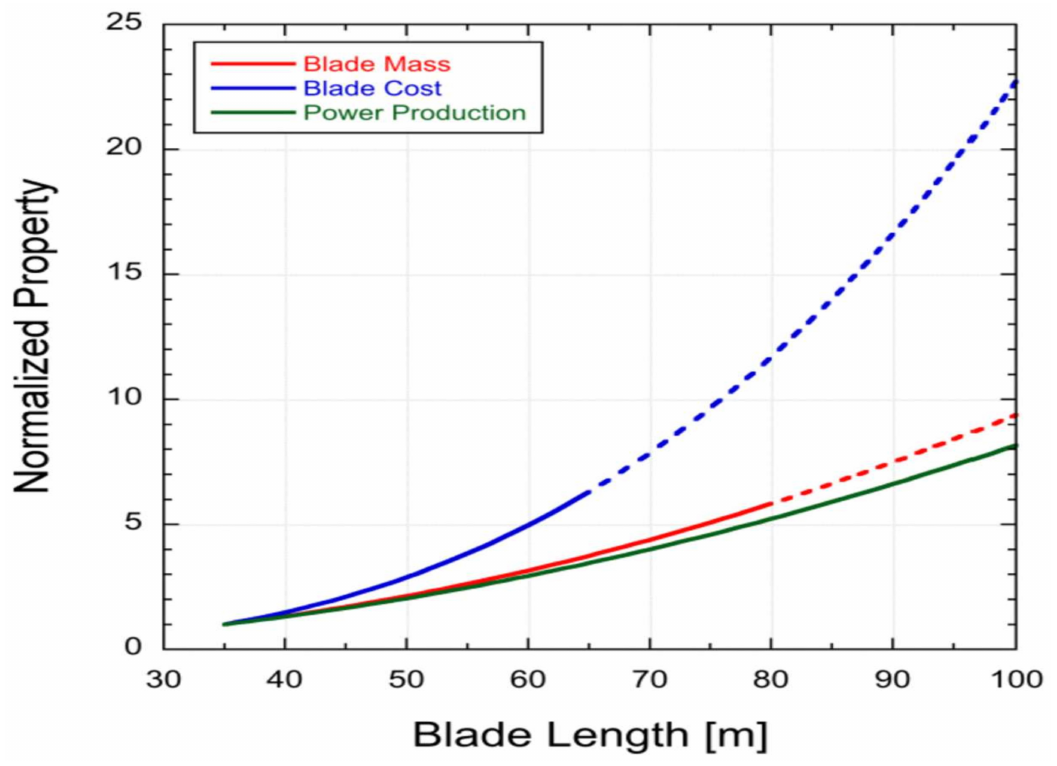
Figure 21. Correlation between the mass, cost, and power produced of a wind turbine. The trends in recent times are denoted in solid lines, whiles the dotted lines are projected values